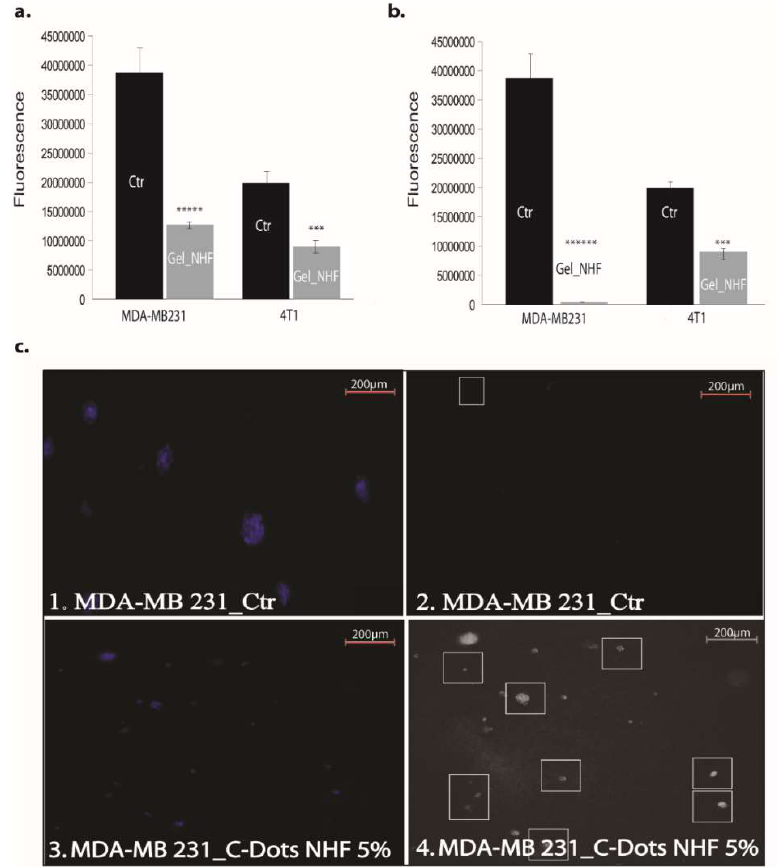
Figure 9. The effects of gels with 5% CD-NHF in 2D and 3D culture. ( a ) Viability of MDA-MB-231 (human breast adenocarcinoma 33.3%) and 4T1 (mouse mammary breast cancer 44.87%) cell lines treated with gels containing 5% CD-NHF ( N = 8 wells/column from two independent experiments);